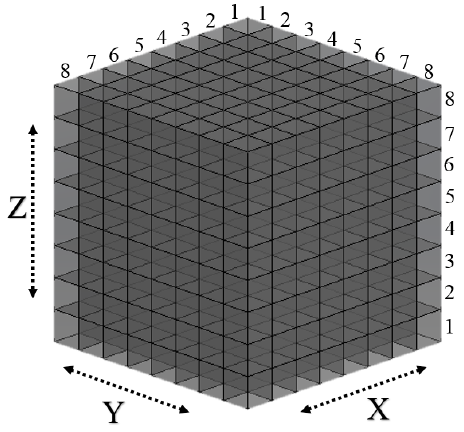
Figure 4. Gridded 3D workspace.